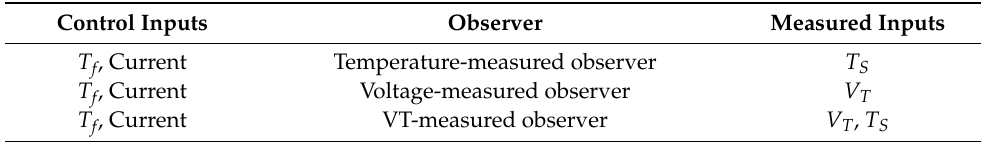
Figure 6. Measured outputs; ( a ) terminal voltage and ( b ) surface temperature. By using the EKF method, three different observers were created. Table 3 shows the three observer’s components. Table 3. The components of the three observers.